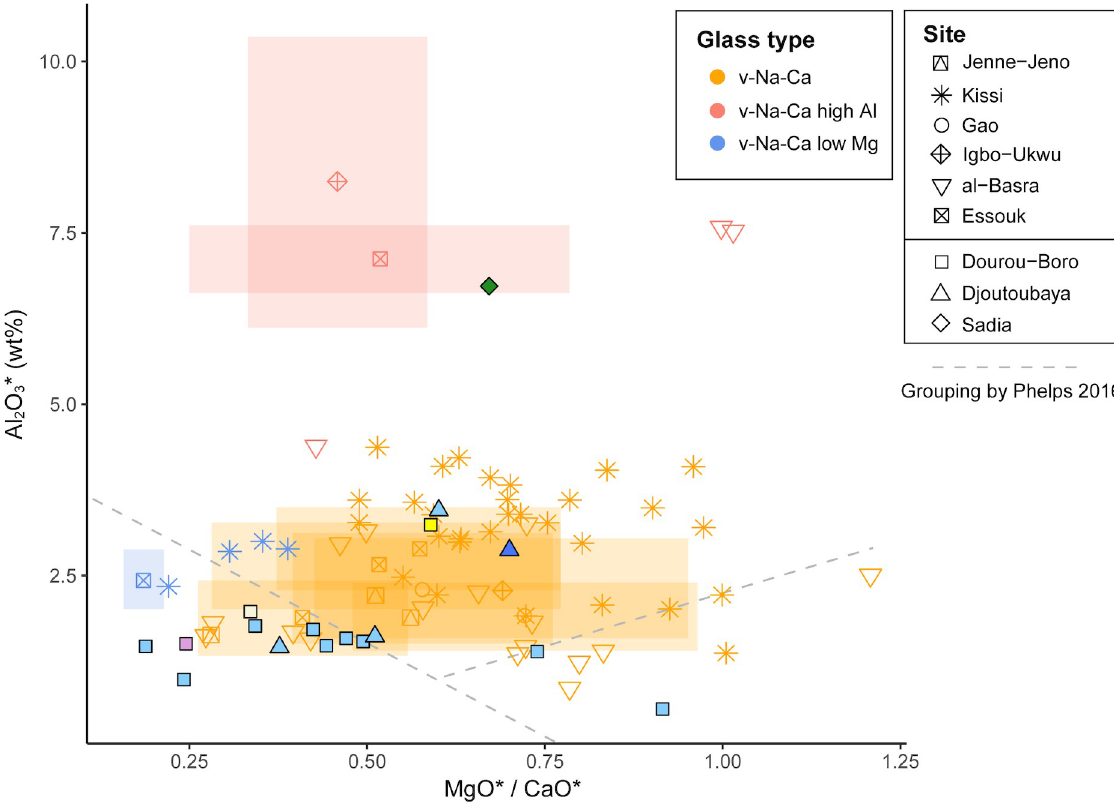
Fig 16. Comparison between contemporary glass bead assemblages from West Africa. Alumina versus magnesia to lime ratios of published compositions of glass beads from West Africa, grouped after Phelps [49, 50].